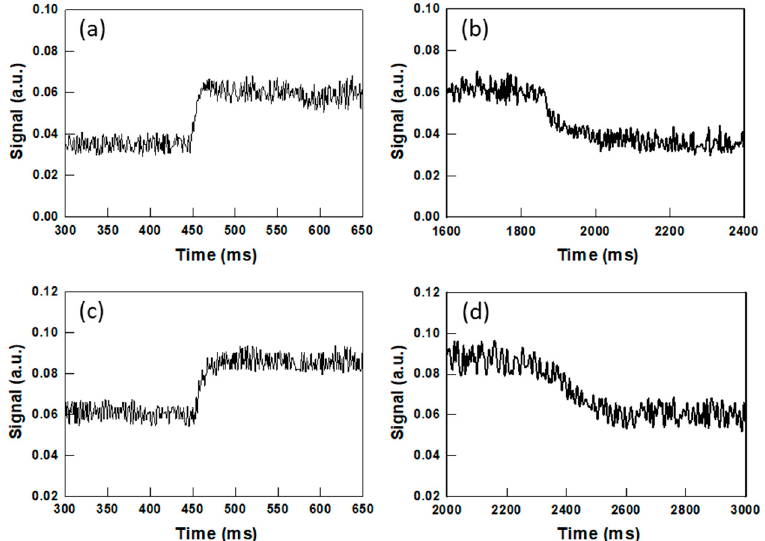
Figure 9. Time evolution of the intensity of the light transmitted by PSCLCs with ( a , b ) 3 ± 0.2 µm and ( c , d ) 5 ± 0.2 µm thickness when a DC voltage is switched on and off. For the PSCLC with 3 µm, a 40 V DC voltage is ( a ) directly applied at t ~ 450 ms and ( b ) removed at t ~ 1850 ms. Rise and fall times are ~30 ms and ~150 ms. For the PSCLC with 5-µm thickness, 45 V DC are ( c ) applied at t ~ 450 ms and ( d ) removed at t ~ 2300 ms. Rise and fall times are ~50 ms and ~200 ms. Adapted from ref. [50].